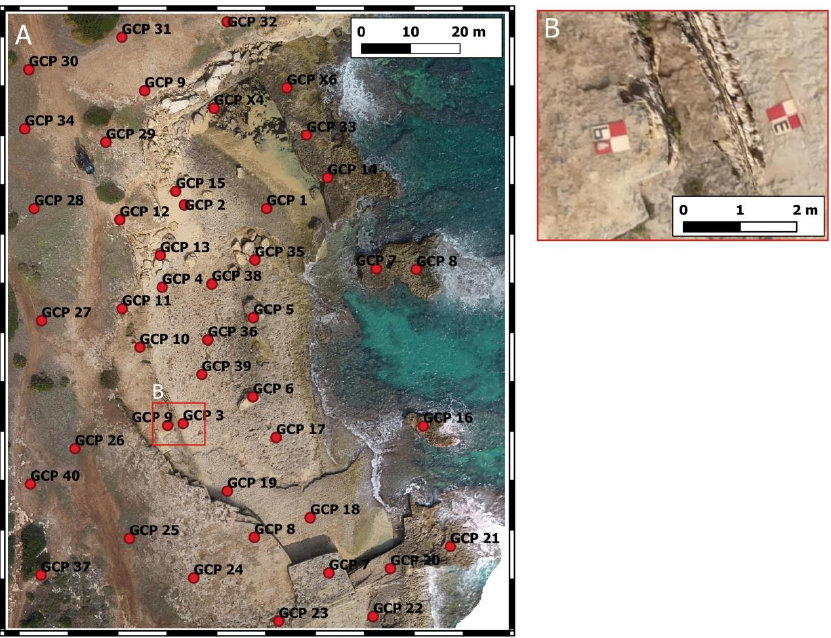
Figure 4. ( A ) Ground control point (GCP) net installed in 2015 and composed of 40 benchmarks regularly spaced along the quarry area. ( B ) Detail of the colored markers positioned on the ground.